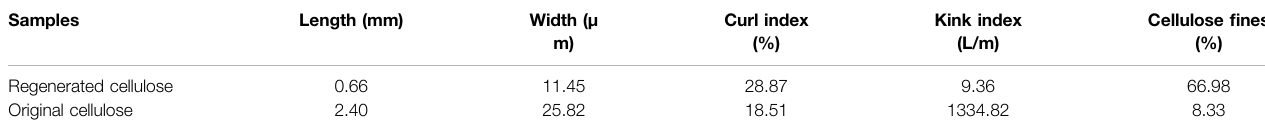
TABLE 1 | Fiber dimension of regenerated cellulose and the original pulp fi bers.